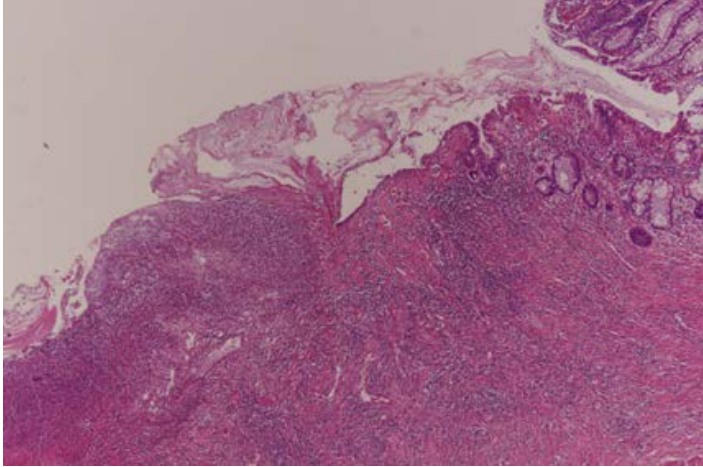
Figure 1. Complete pathologic response (TRG0); x 40 HE; Mucosal ulcer area, no residual tumor.